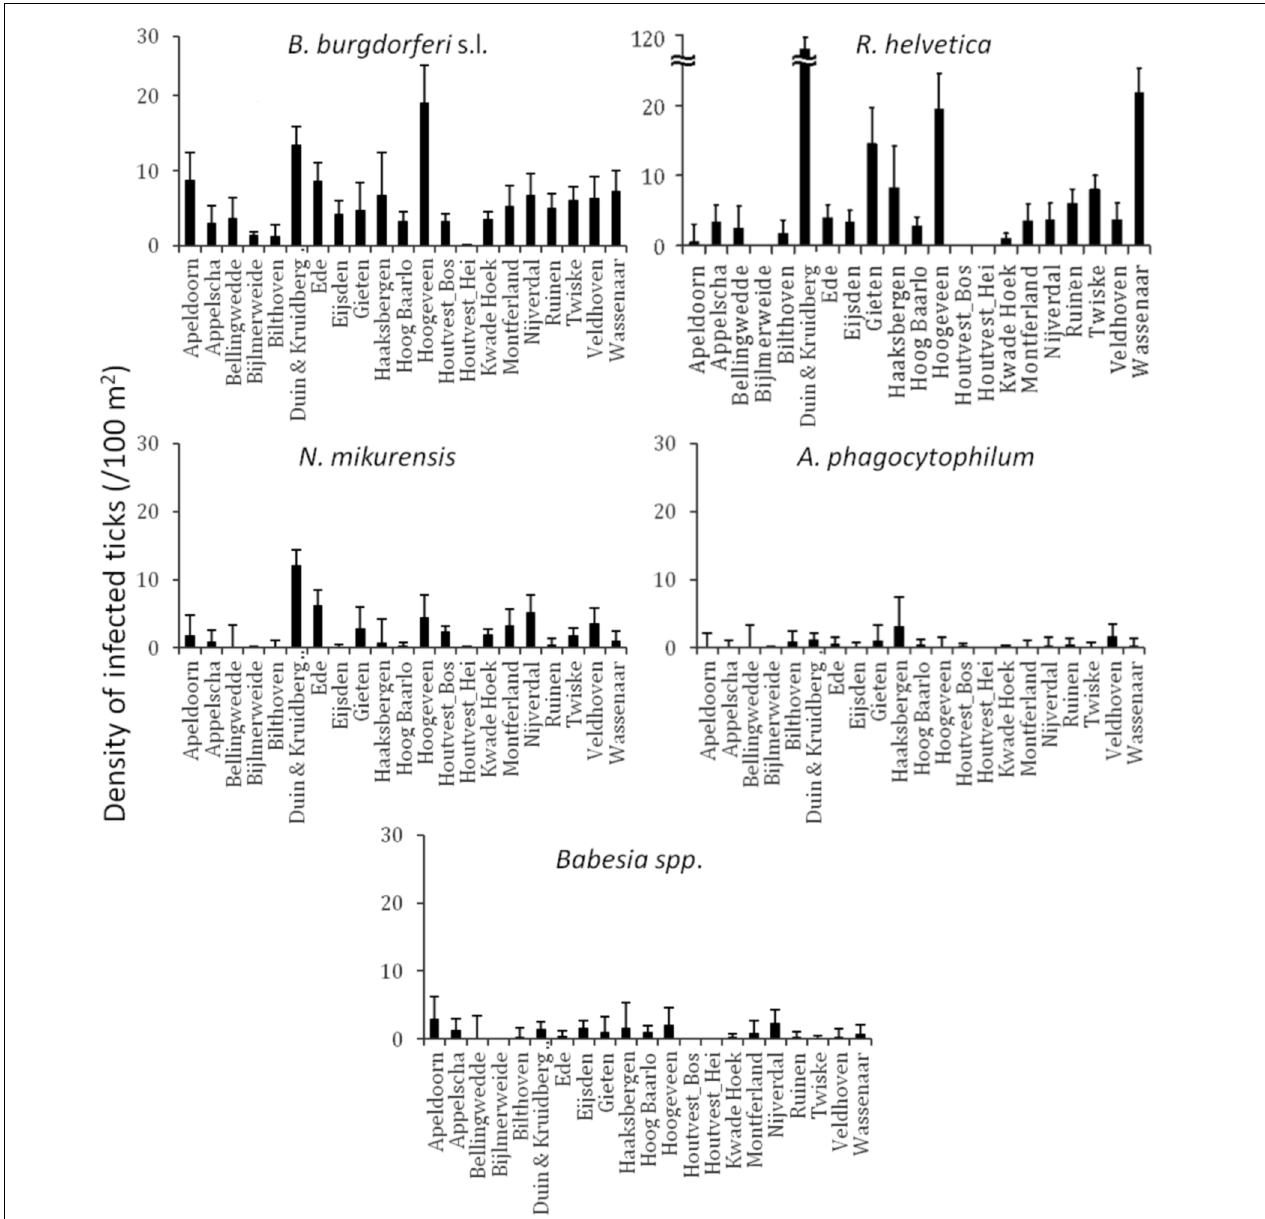
FIGURE 2 | Identification of high risk-areas depends on both prevalence and tick density/activity. Their calculated product defines the density/activity of infected ticks (nymphs and adults/100m 2 ). The